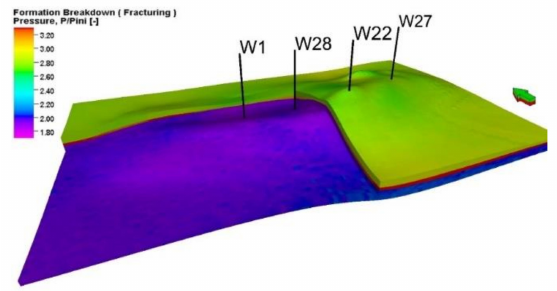
Figure 28. Distribution of the formation breakdown pressure within the Borz˛ecin